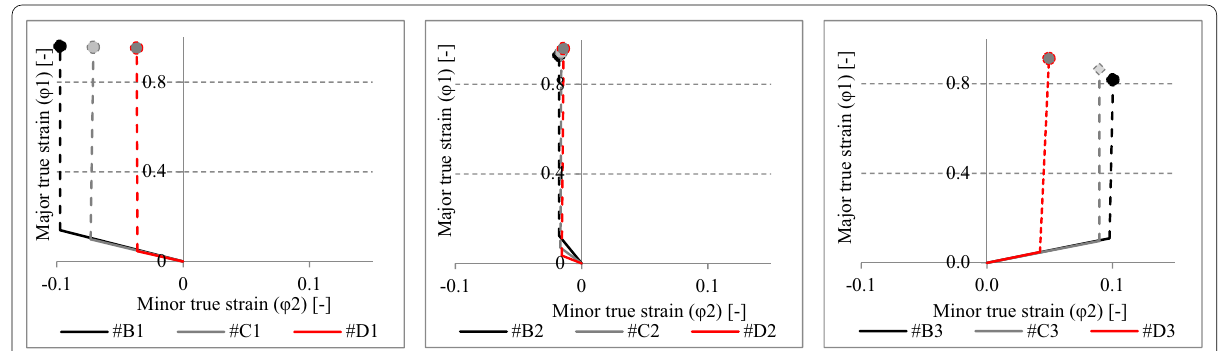
Figure 17 Forming paths (experimental) during the hybrid